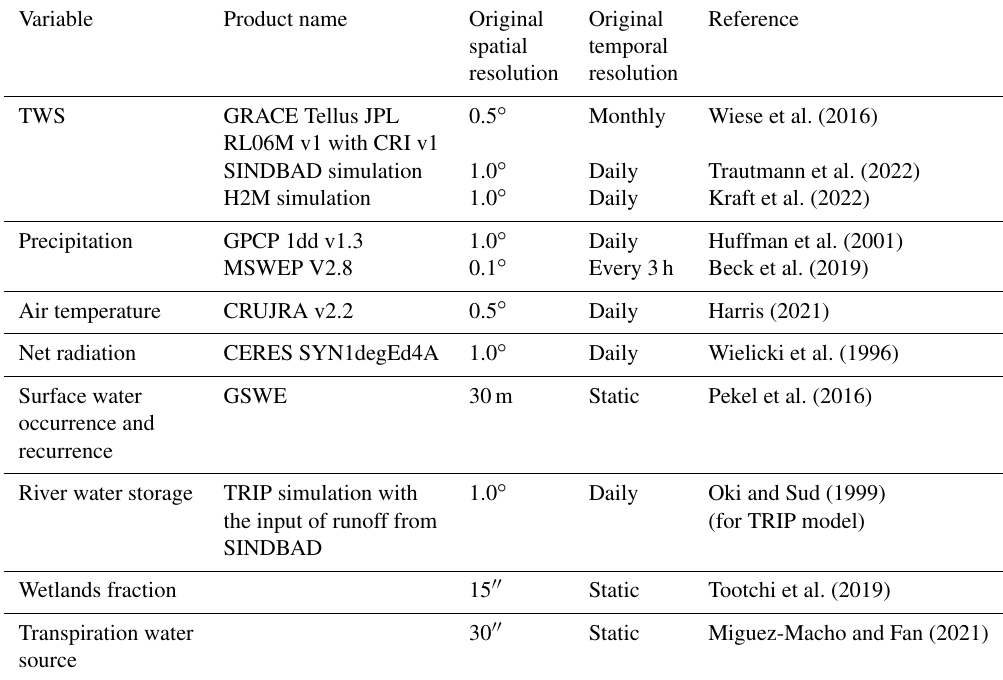
Table 1. Data used to associate with modeled terrestrial water storage (TWS)